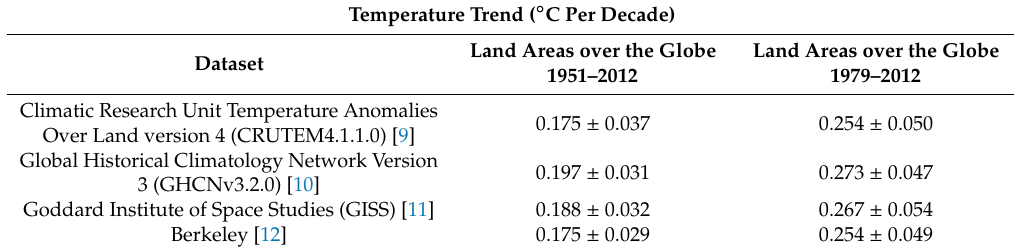
Table 3. Linear trend in global land surface air temperatures over two periods, 1951–2012 and 1979–2012 (IPCC, 2013).